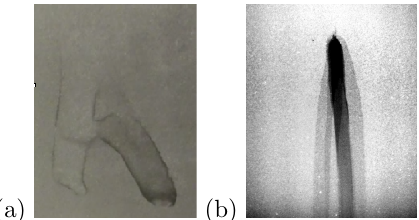
Figure 10: Water droplet – (a) Typical dirt released after drawing on frosted glass. The liquid evaporates leaving dirt along the contact line. (b) Superimposition of 5 pictures obtained after the passage and complete evaporation of 5 successive droplets.